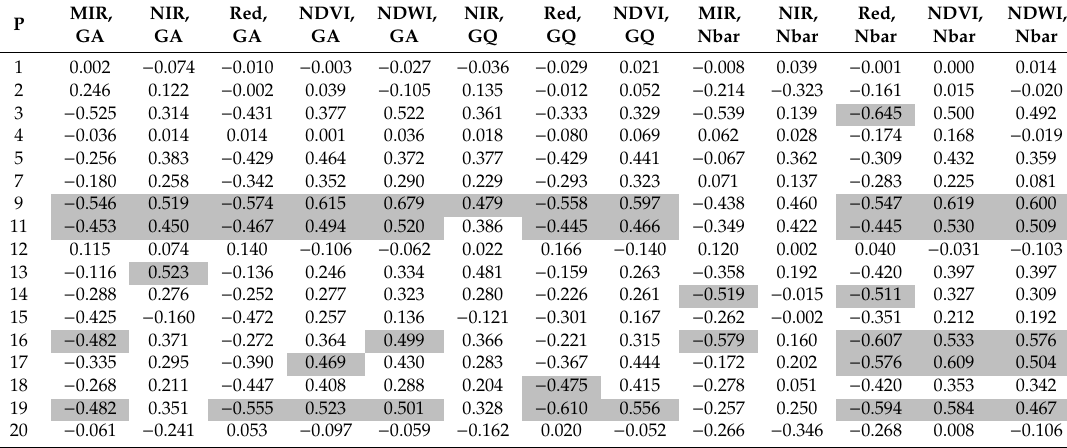
Table 4. Pearson correlation coe ffi cients between height and daily MODIS satellite variables for every analysed paddock (P). Significant ( p < 0.05) correlation coe ffi cient values are shaded in grey. MIR: Middle infrared band, NIR: Near infrared band, Red: Red band, NDVI: Normalized di ff erence vegetation index, NDWI: Normalized di ff erence water index. Nbar (MODIS / Terra and Aqua Nadir BRDF (bidirectional reflectance distribution function) adjusted reflectance (NBAR), 500 m), GA (MODIS Terra / Aqua Surface Reflectance 500 m), and GQ (MODIS Terra / Aqua Surface Reflectance 250 m) refer to the MODIS daily products analyzed.